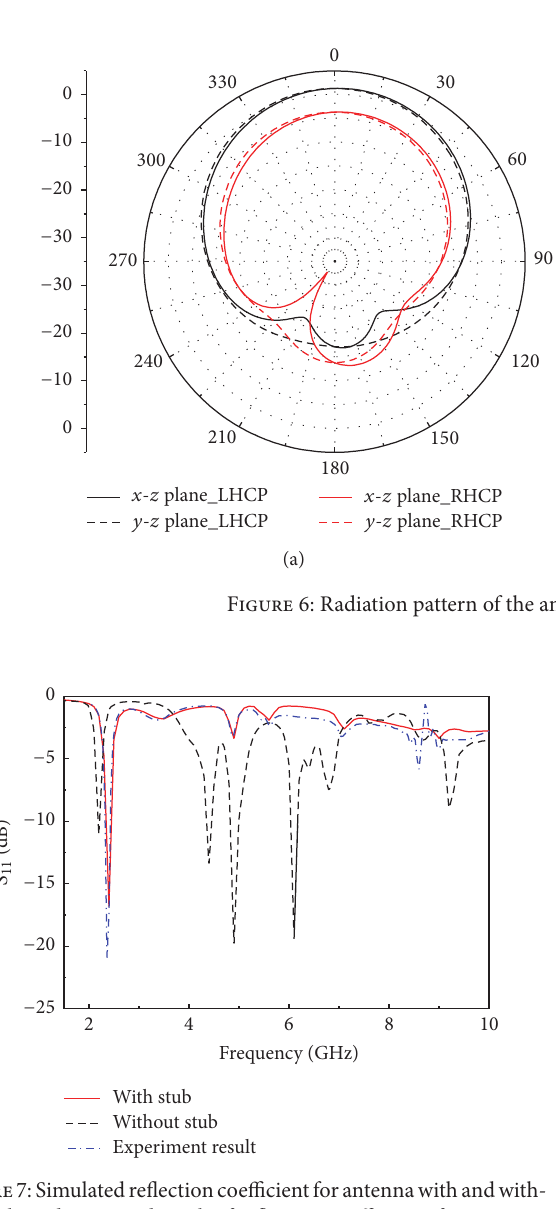
Figure7:Simulatedreflectioncoefficientforantennawithandwith- out stub, and measured result of reflection coefficient of antenna.